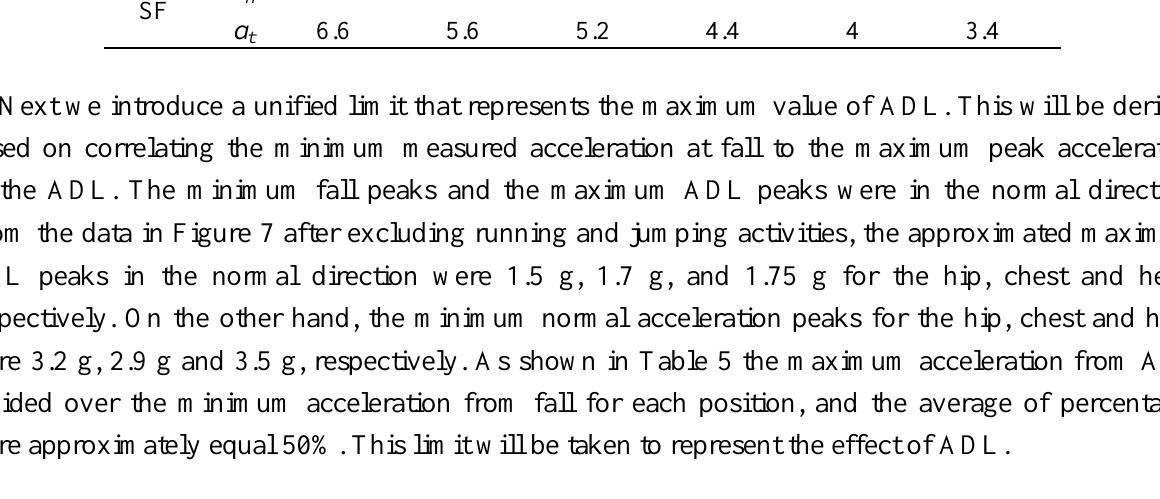
Table 5. ADL as a 50% of the fall